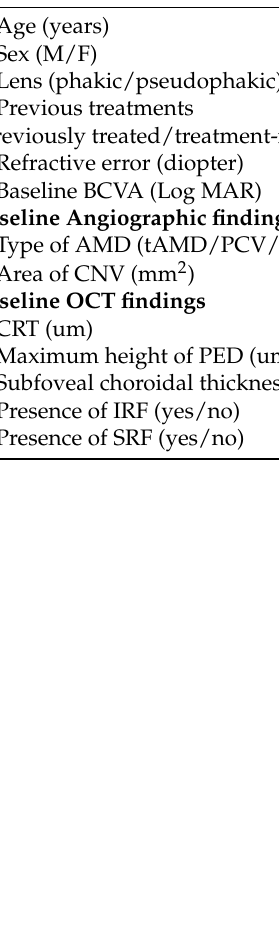
Table 2. Changes after three monthly loading injections of